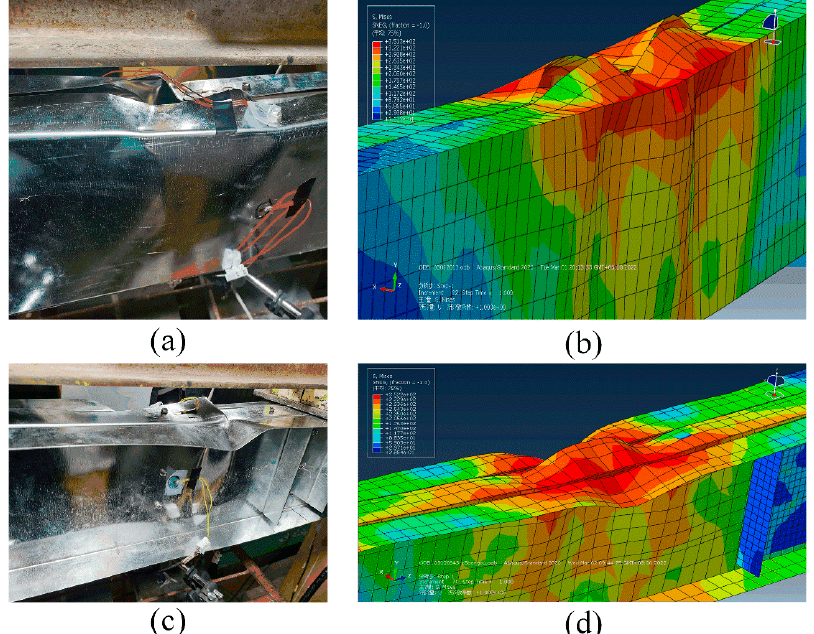
Figure 8. Comparison of experimental and FE analysis results. ( a ) B4 beam in the experiment test; ( b ) B4 beam in the FE analysis; ( c ) K4 beam in the experiment test; ( d ) K4 beam in the FE